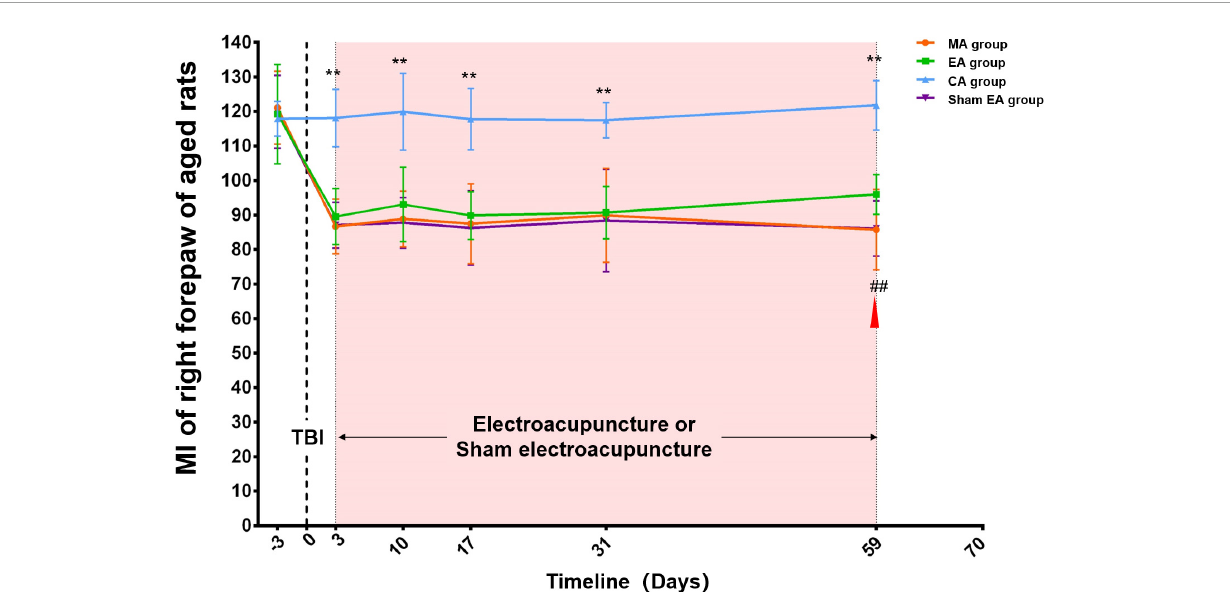
FIGURE2 Catwalk gait analysis of the right (injured) forepaw in aged rat groups. At baseline, there was no difference among the four groups (MA, EA, CA, and sham EA groups) ( p > 0.05). After TBI, the MI of right forepaw of aged rats in MA, EA and sham EA groups showed an obvious decrease compared with that in the CA group. During the subsequent observation process, there was an increase in these three groups. Throughout the experimental procedure, the MI of the right forepaw in the CA group was stable and significantly higher than that in the MA group ( p < 0.01). After 8 weeks (day 59 post-TBI) of intervention, the MI of aged rat right forepaw in the EA group increased significantly compared with that in the sham EA group ( p < 0.01). TBI establishment was showed by the dotted line. Mean and SD were expressed by the points and bars. The duration of electroacupuncture or sham electroacupuncture intervention was marked out with the pink shadow. The red triangle represented the starting point of electroacupuncture for improving the aged rats’ MI. MA group, aged model group; EA group, aged electroacupuncture group; CA group, aged control group; sham EA group, aged sham electroacupuncture group; TBI, traumatic brain injury; MI, the mean intensity. **Represented a significant difference between the CA and MA groups at the same time point ( p < 0.01). ##Represented a significant difference between the EA and sham EA groups at the same time point ( p <